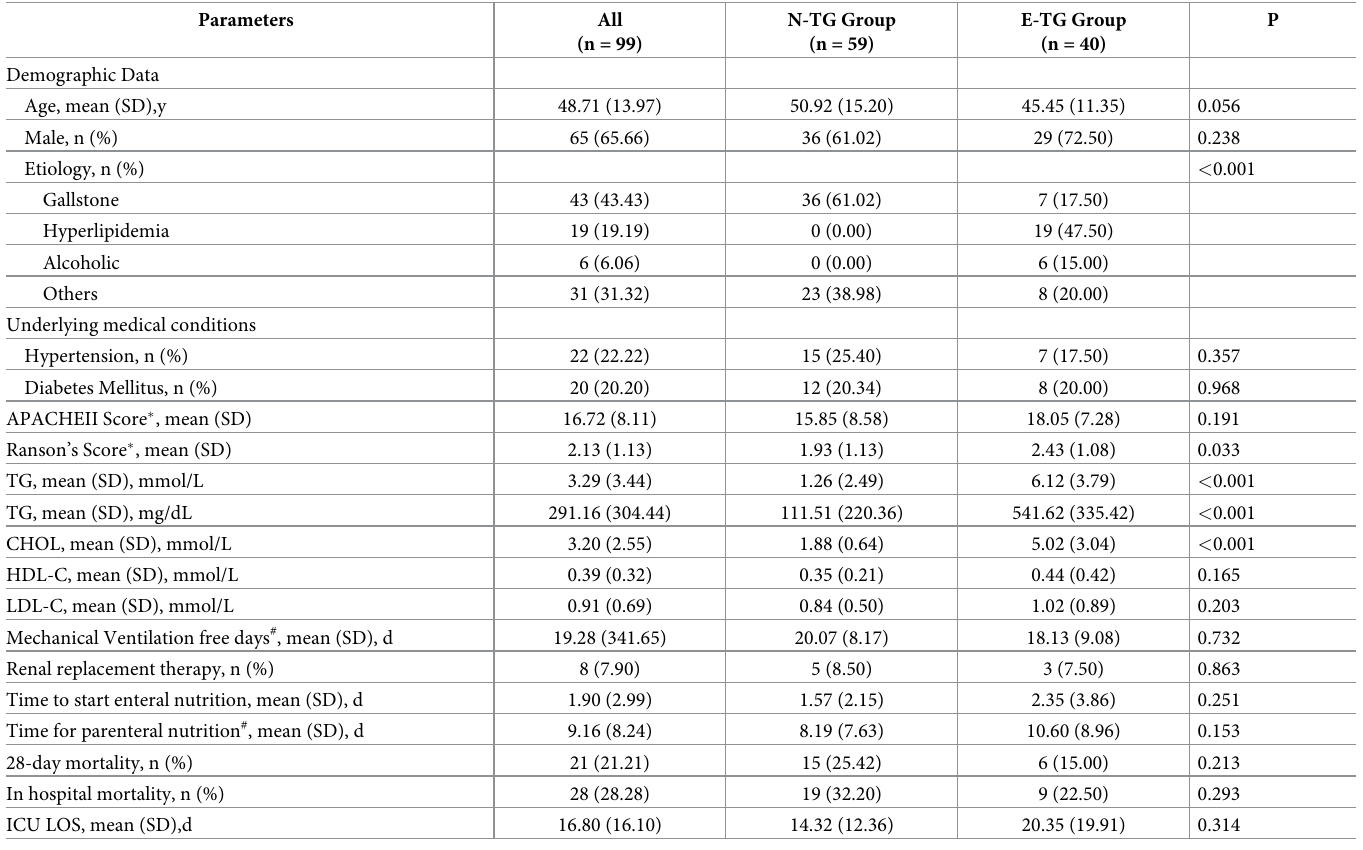
Table 1. Demographics, clinical and outcome data of SAP patient